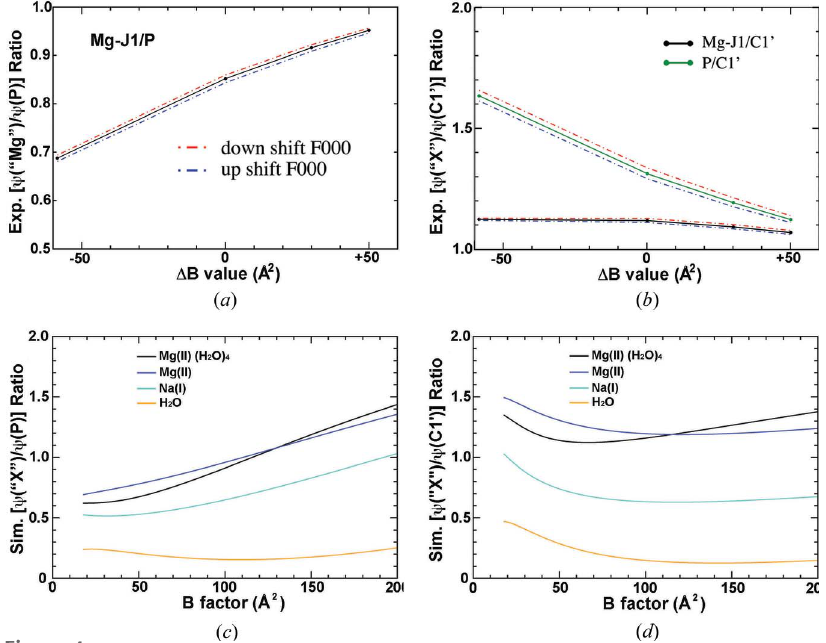
Figure 4 The experimental and theoretical ESP ratios at Mg-J1 site. ( a ) Experimental [ (‘Mg’)/ (P)] ratio (black) with a down shifted F (0,0,0) term (red) and an up shifted F (0,0,0) term (blue) added. ( b ) Experimental [ (‘ X ’)/ (C1 0 )] ratios for Mg-J1 and P. ( c ) Simulated ESP ratios in reference to the nearest P atom. ( d ) Simulated ESP ratios in reference to the nearest C1 0